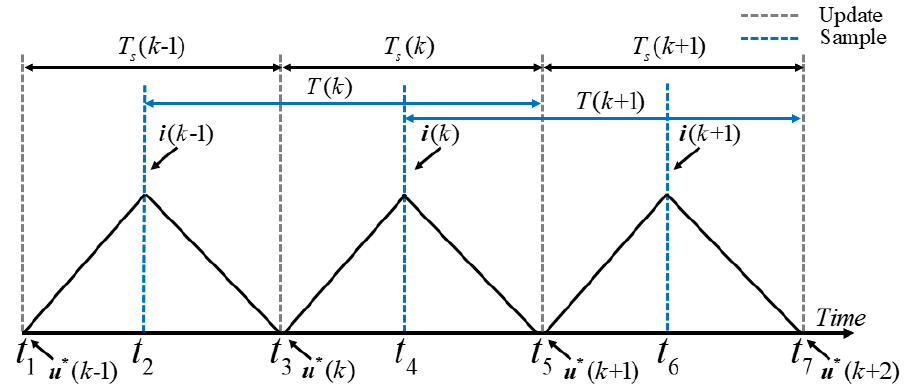
Figure 5. Current predictive period analysis based on PWM time - sequence.